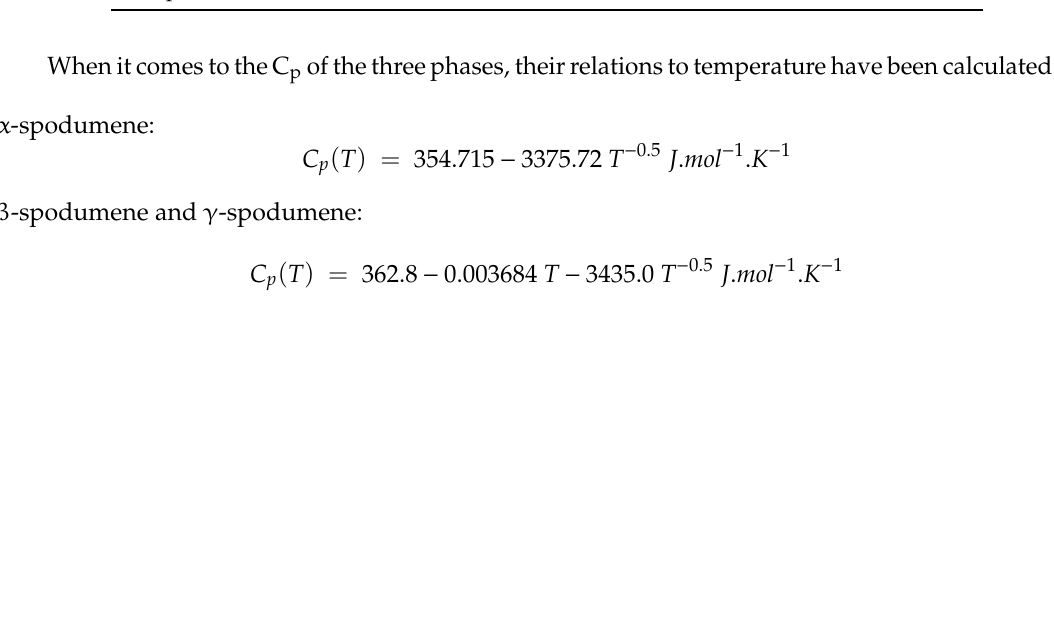
Table 3. Data of the different spodumene phases [40,41] (adapted with permission from Springer Nature, Contributions to Mineralogy and Petrology; published by Springer Nature, 2019) . Table 2. Crystallographic data of the di ff erent spodumene structures [34,38,39]. Form Structure Space Group